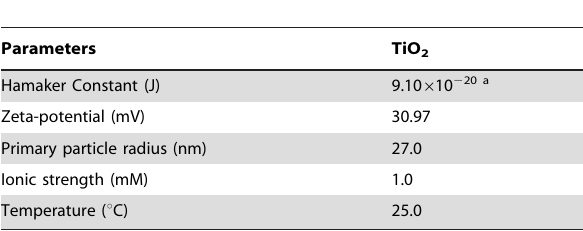
Table 1. Parameters used in the DLVO